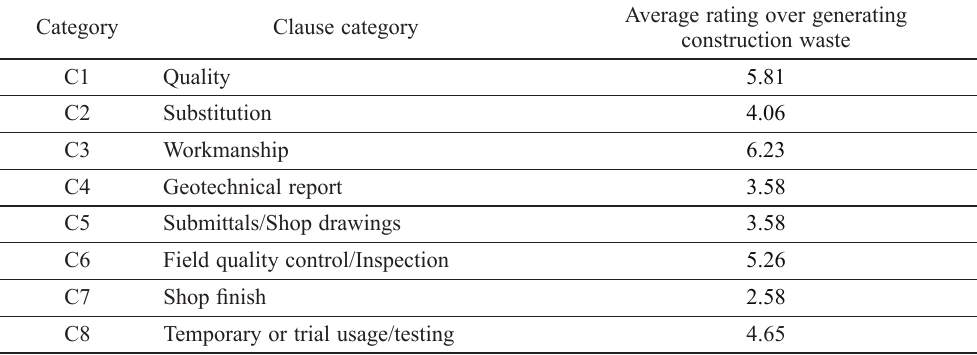
Table 5. Ranking of clause categories in terms of potential/influence on generating construction